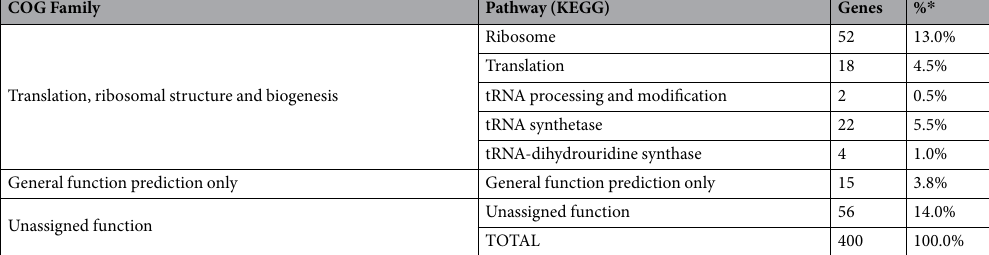
Table 1. COG and KEGG classification of B. breve essential genes. * Percentage of the protein encoding predicted essential genes from B. breve UCC2003, mapped into each COG and KEGG functional